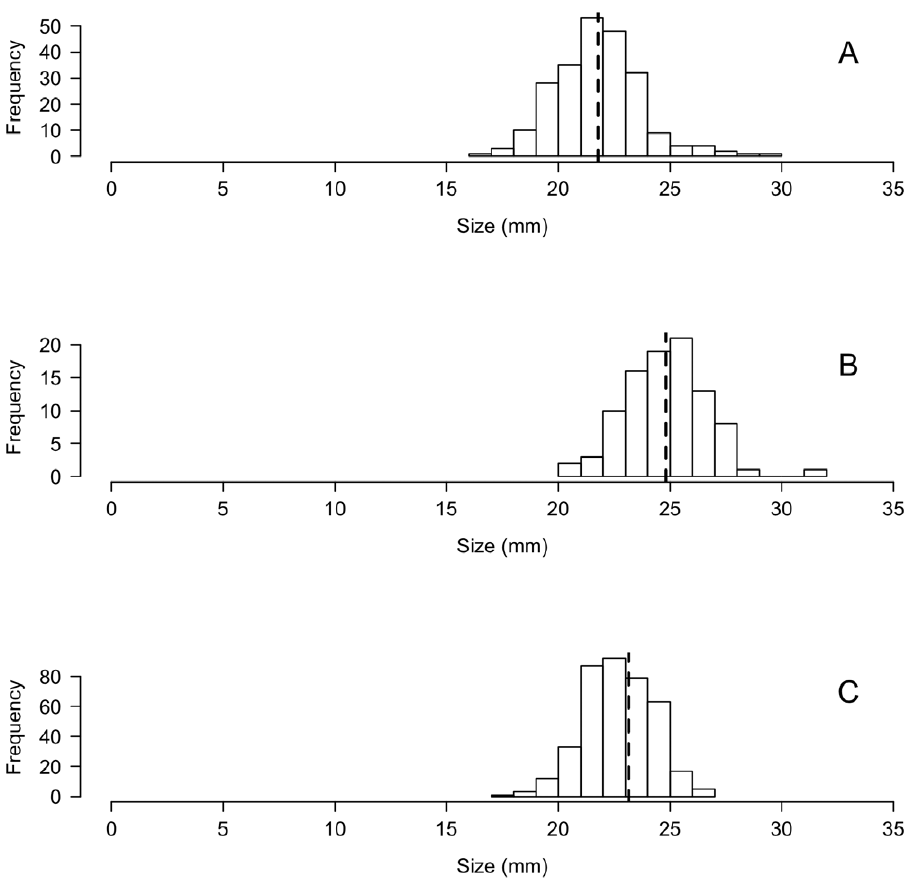
Figure 3. Size-frequency distributions of recently discovered Littorinalittorea populations. No juveniles are present in any of the three populations. (a) Anaheim Bay (n=231, mean=21.77 mm, SD=1.93 mm), (b) Ashby Spit (n=94, mean=24.82 mm, SD=1.86 mm), and (c) Dumbarton Pier (n=392, mean=23.15 mm, SD=1.58 mm). Not all snails were available for measurement. Dashed line indicates mean.